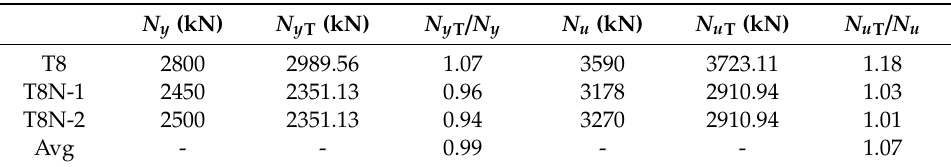
Table 5. Theoretical calculation